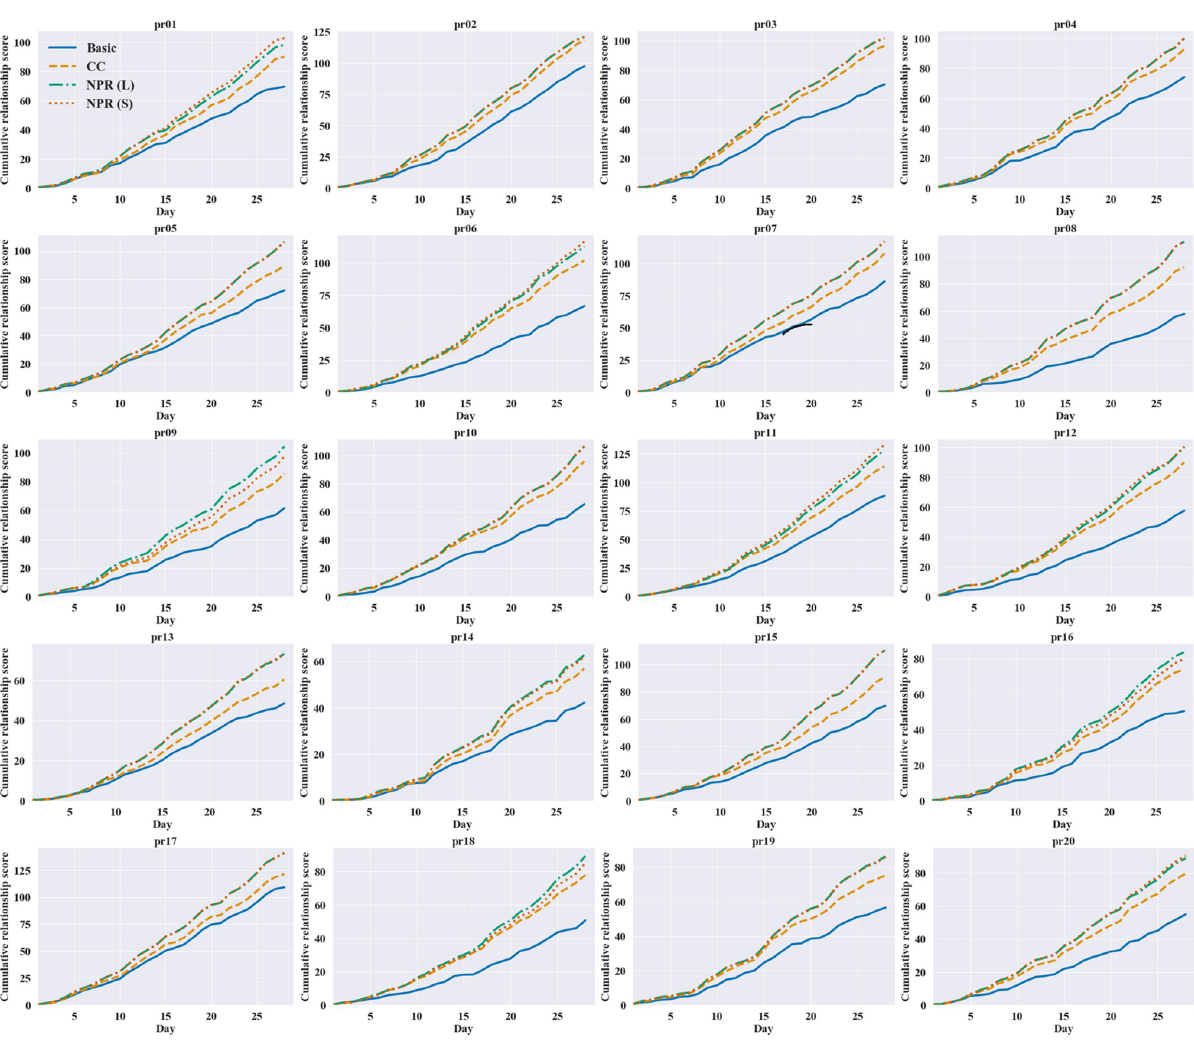
Fig 2. Cumulative total relationship scores over the 28-day